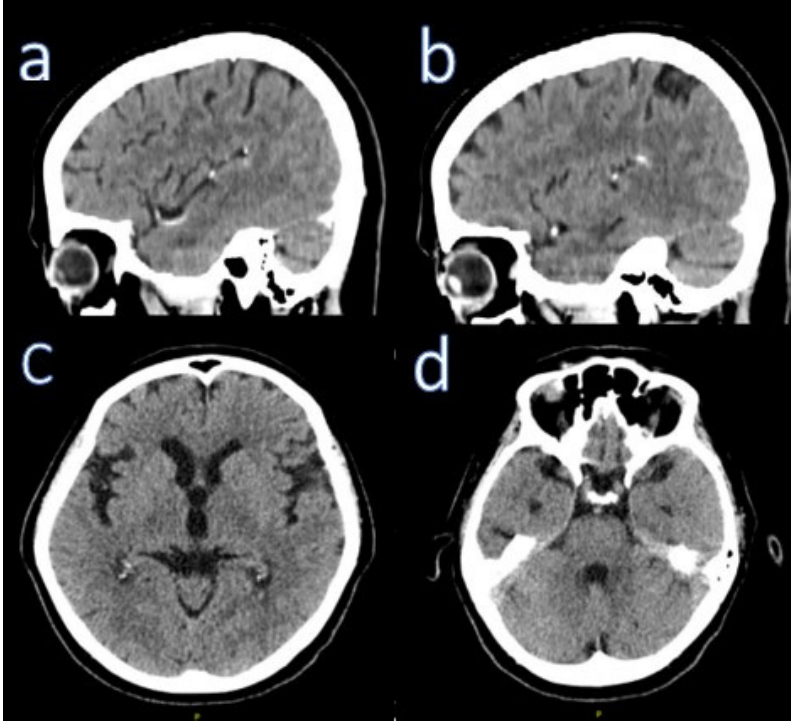
Figure 1. CT of Case 1 taken after first presentation in outpatients’ clinic. Sagittal ( a , b ) and axial ( c , d ) CT projections.